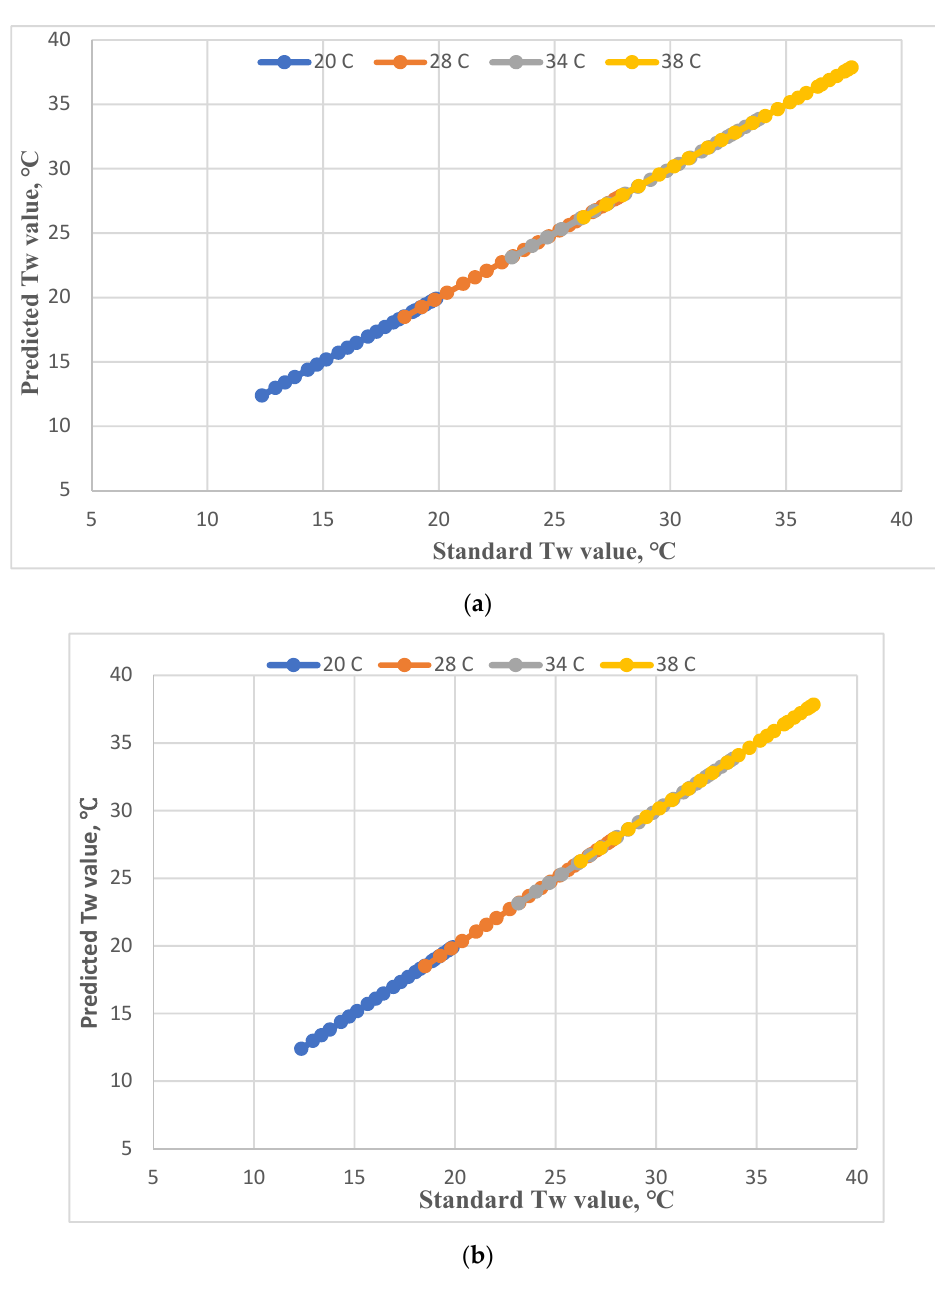
Figure 3. The parity plot of the prediction Tw values and the standard Tw value. ( a ) Model I, ( b ) Model II. The Stull equation had the highest criteria for 𝑒 (cid:3040)(cid:3028)(cid:3051) , 𝑒 (cid:3040)(cid:3036)(cid:3041) , |𝑒| (cid:3028)(cid:3049)(cid:3032) and 𝑒 (cid:3046)(cid:3031) , possibly because the range of Td and RH is different for this study. To develop the Tw equation, Stull [35] used Gene-expression programming to determine the best-fitting equation. The Td value of − 20 to 50 °C and humidities of 5% to 99% was used in the study by Stull [35]. This study develops the equation to predict Tw using regression analysis. The Td and RH values range from 20 °C to 45 °C, and 40% to 99%, respectively. The predictive ability of Models I and II is better than that of the Stull equation. For an environment with a higher air temperature and humidity, Model I has the acceptable predictive ability and a simple form.